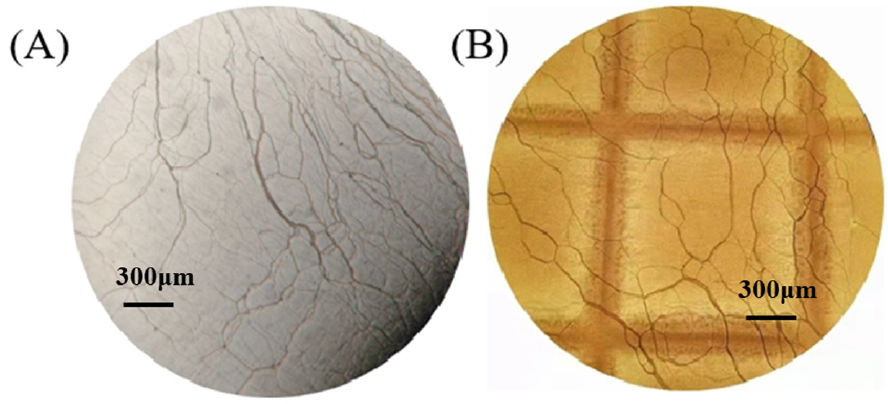
Figure 3. Texture composition before ( A ) and after curing ( B ).